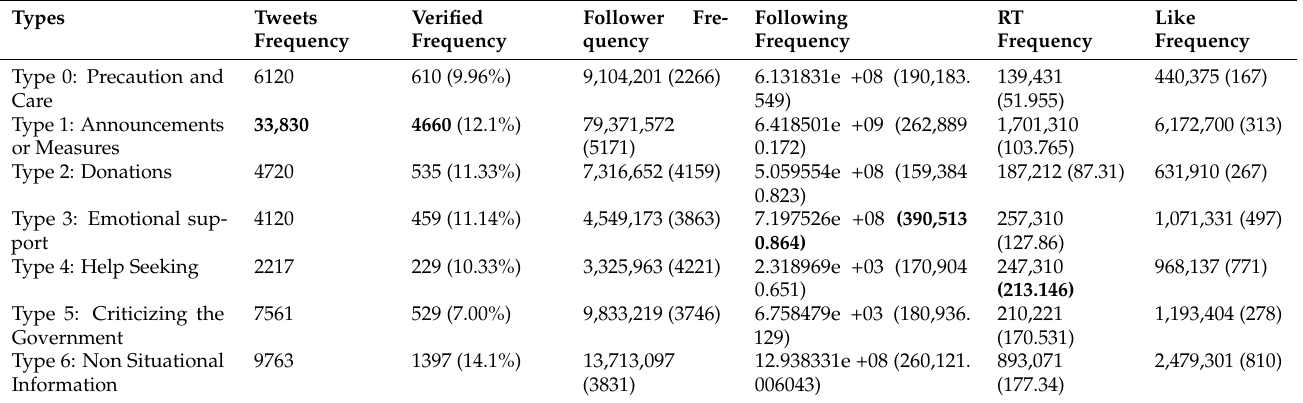
Table 3. Mean values of extracted dataset features of each information category, and bold values indicates the highest values in that specific